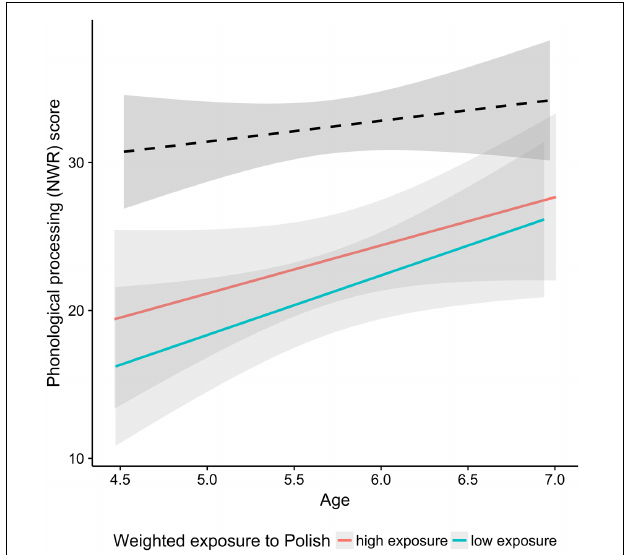
FIGURE 7 | Scores in the phonological processing test plotted as a function of age. The black dashed line indicates the monolingual group and the two colored lines correspond to the bilingual group. Red and aqua correspond to the median split on exposure to L1 Polish. The median split was performed for visualization purpose only.